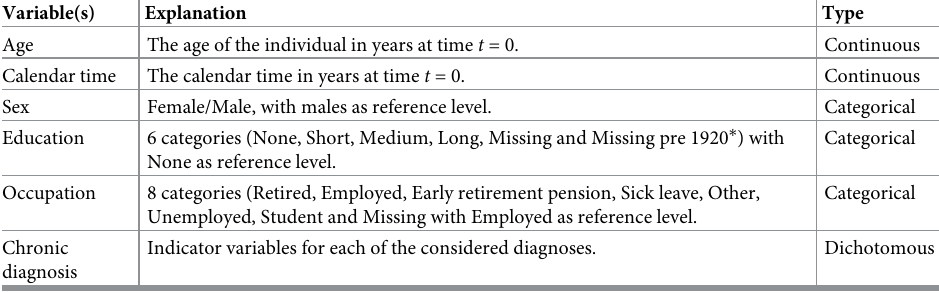
Table 1. Overview of explanatory variables in the statistical